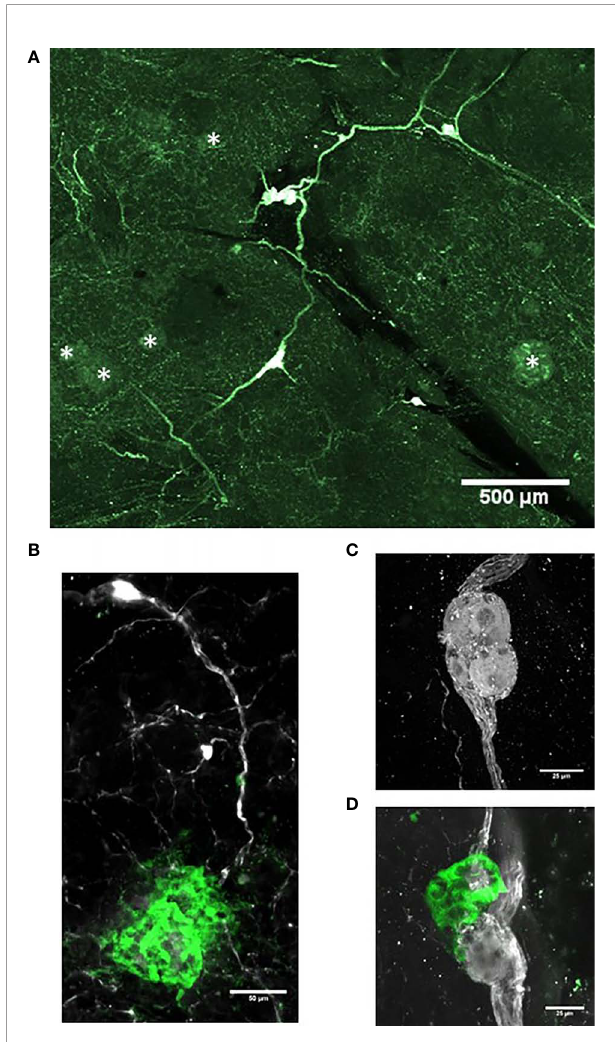
FIGURE 3 | Intrapancreatic ganglia and neuroinsular complexes in adult human pancreas. Pancreas samples were studied in control donors using passive CLARITY (PACT) and immunostaining with primary antibodies for PGP9.5 (white) and GFAP (green) to delineate nerve fi bers and supporting Schwann cells, respectively ( Table 2 ). PGP9.5 also stained islet endocrine cells although with much less intensity (asterisks). Intrapancreatic ganglia represent post-ganglionic neurons and fi bers of the parasympathetic efferent system and 3-D imaging shows how ganglia are interconnected (A) and also extend to islets (B) . (C) Intrapancreatic ganglia contained varying numbers of neurons and small collections of neurons were also found widely scattered with efferent and afferent axons in both interlobular and intralobular regions. (D) Imaging for PGP9.5 and islet alpha-cells (GCG, green) demonstrate close association of clustered alpha-cells with neurons at a small ganglion, also known as a neuro-insular complex II. Scale bars: 500µm (A) , 50µm (B) , 25 µm (C, D) . See also Supplementary Video 2 for (D)